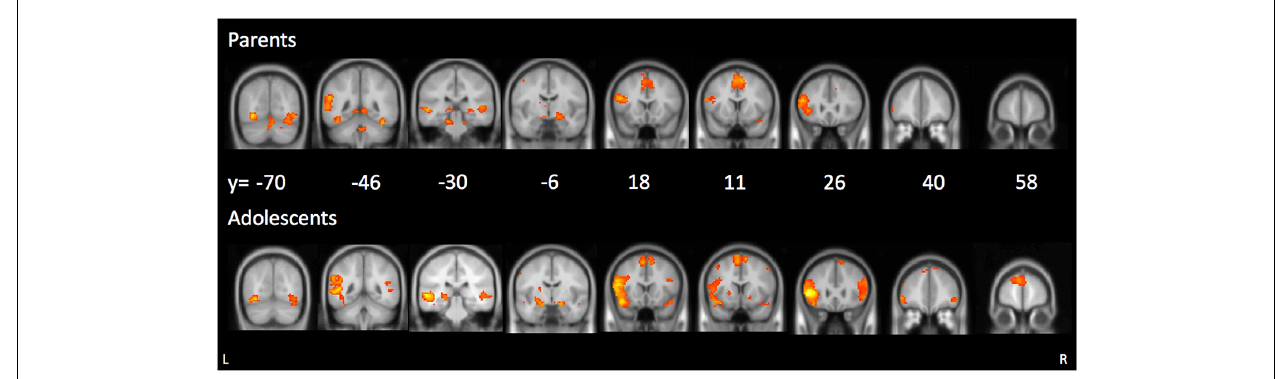
FIGURE 2 | Main effects during affect labeling for parents (top panel) and adolescents (bottom